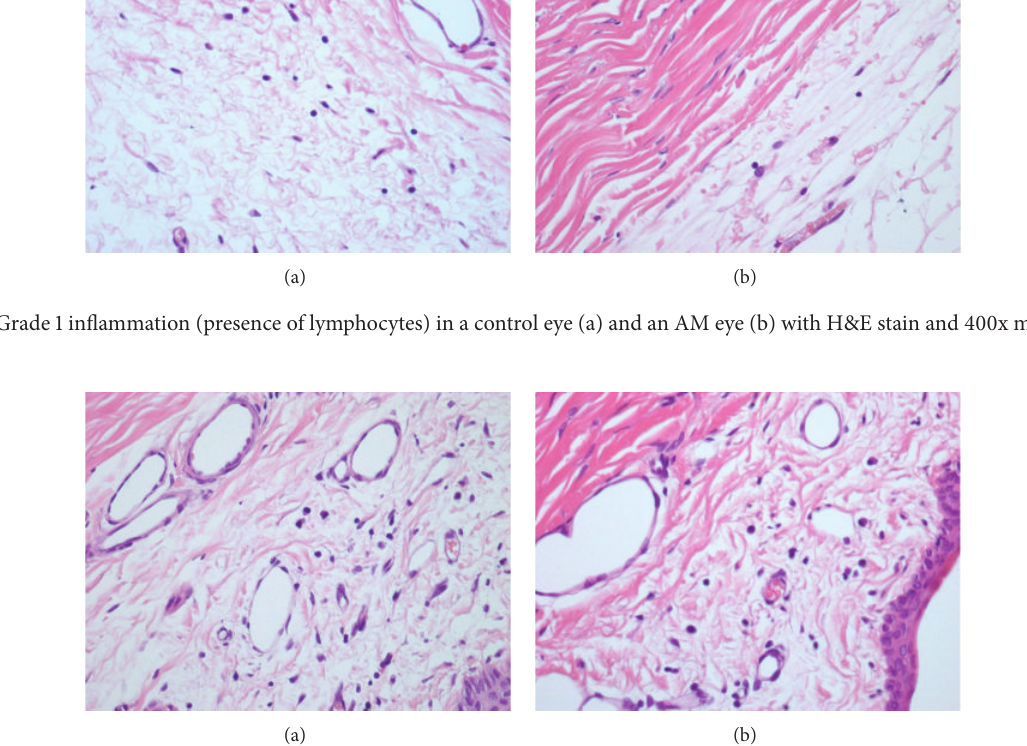
Figure 2: Grade 2 inflammation (presence of lymphocytes, plasmocytes, and macrophages) in a control eye (a) and an AM eye (b) with H&E stain and 400x magnification.